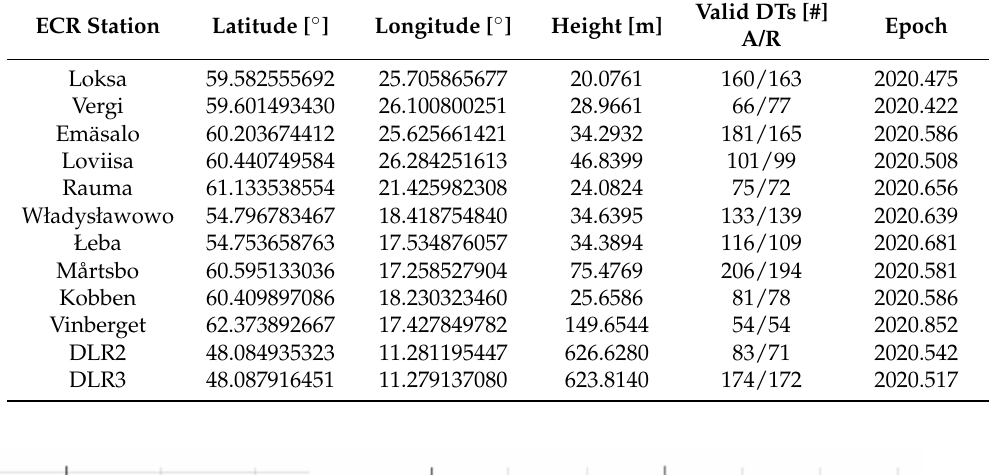
Table 4. Estimated average GRS-80 ellipsoidal coordinates for year 2020 (longitude, latitude, height) for all stations using all available observations in the year 2020. The epoch is defined as the mid of the total observation period (see Table 1). The number of all valid observations is defined as the number of acquired observations (as shown in Table 1) minus outliers (A: Azimuth, R: Range observations).